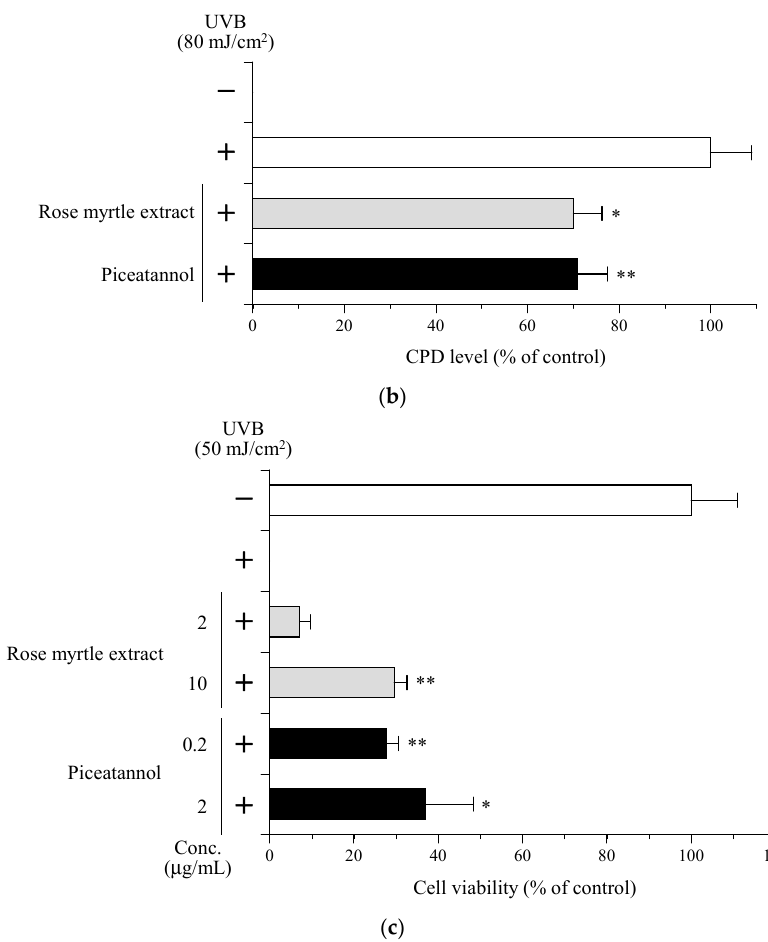
Figure 7. Effect of piceatannol purified from rose myrtle extract as a Pol enhancer on the bioactivities of UVB ‐ exposed NHEKs. ( a ) The activity of cellular Pols. NHEKs were cultured with or without rose myrtle extract (10 μ g/mL) or piceatannol (2.0 μ g/mL) for 24 h, and then NHEKs were cultured for 8 h after UVB (100 mJ/cm 2 ) irradiation. Cellular Pol activity in the treated NHEKs was measured. Gray bars represent human whole Pol (standard reaction conditions without 120 mM KCl), and black bars represent DNA repair ‐ related Pol species (with 120 mM KCl), respectively. Pol activity of vehicle control without UVB irradiation was arbitrarily designated 100%. All data are expressed as mean ± SEM ( n = 3). * p < 0.05 and ** p < 0.01 compared with the UVB + vehicle control; ( b ) UVB ‐ induced CPD production. Before UVB (80 mJ/cm 2 ) irradiation, NHEKs were incubated with rose myrtle extract (10 μ g/mL) or piceatannol (2.0 μ g/mL). Quantitative evaluation of CPDs by DNA ‐ ELISA was performed. Vehicle control CPD production with or without UVB irradiation was 100% or 0%, respectively. All data are expressed as mean ± SEM ( n = 6). * p < 0.05 and ** p < 0.01 compared with UVB + vehicle control; ( c ) Cell viability of NHEKs irradiated with UVB (50 mJ/cm 2 ), and treated with rose myrtle extract (2 and 10 μ g/mL) or piceatannol (0.2 and 2 μ g/mL). MTT [3 ‐ (4,5 ‐ dimethylthiazol ‐ 2 ‐ yl) ‐ 2,5 ‐ diphenyl tetrazolium bromide] assays evaluated living cell numbers at 24 h after treatment. Vehicle control cell viability with or without UVB irradiation was arbitrarily designated 0% or 100%, respectively. All data are the mean ± SEM ( n = 6). * p < 0.05 and ** p < 0.01 compared with the UVB + vehicle control.